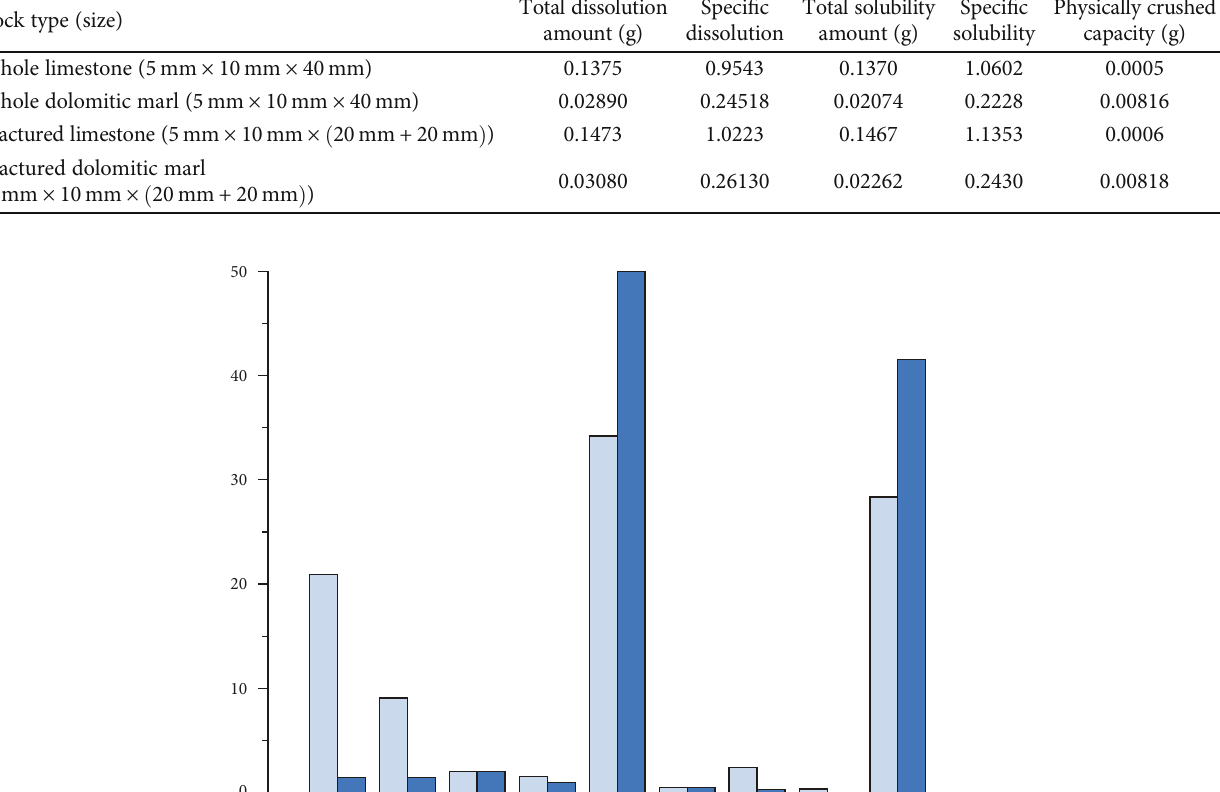
Table 2: Comparison table of dissolution and dissolution of main types of Ordovician karst in the study area. Rock type